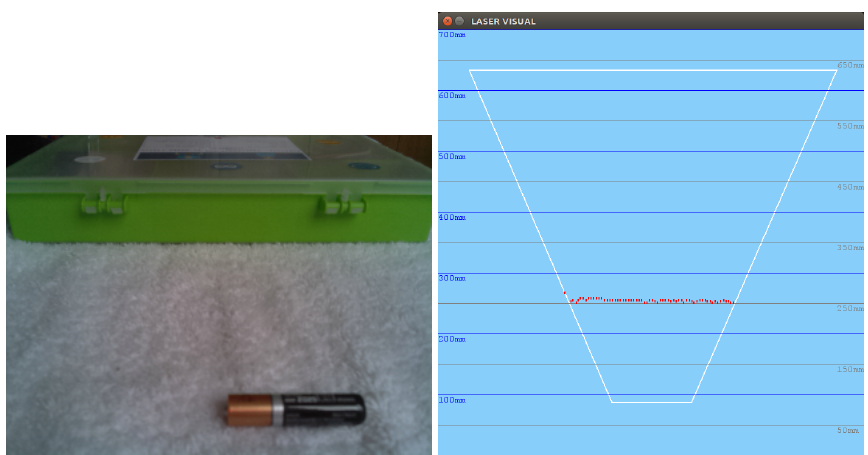
Figure 12. Example of visual sonar reading with 25 cm object shown using 3D scene